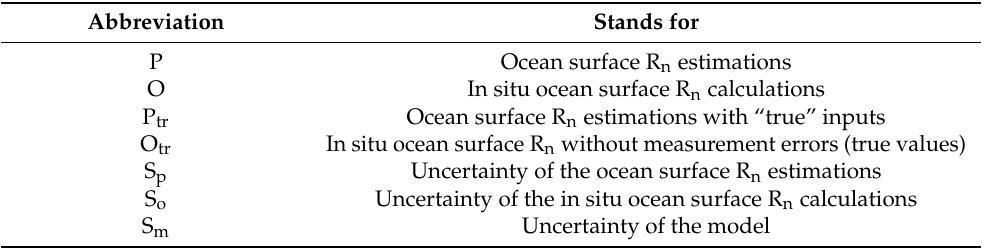
Figure 16. Validation results of CERES-based R n estimates. Table 5. Variable